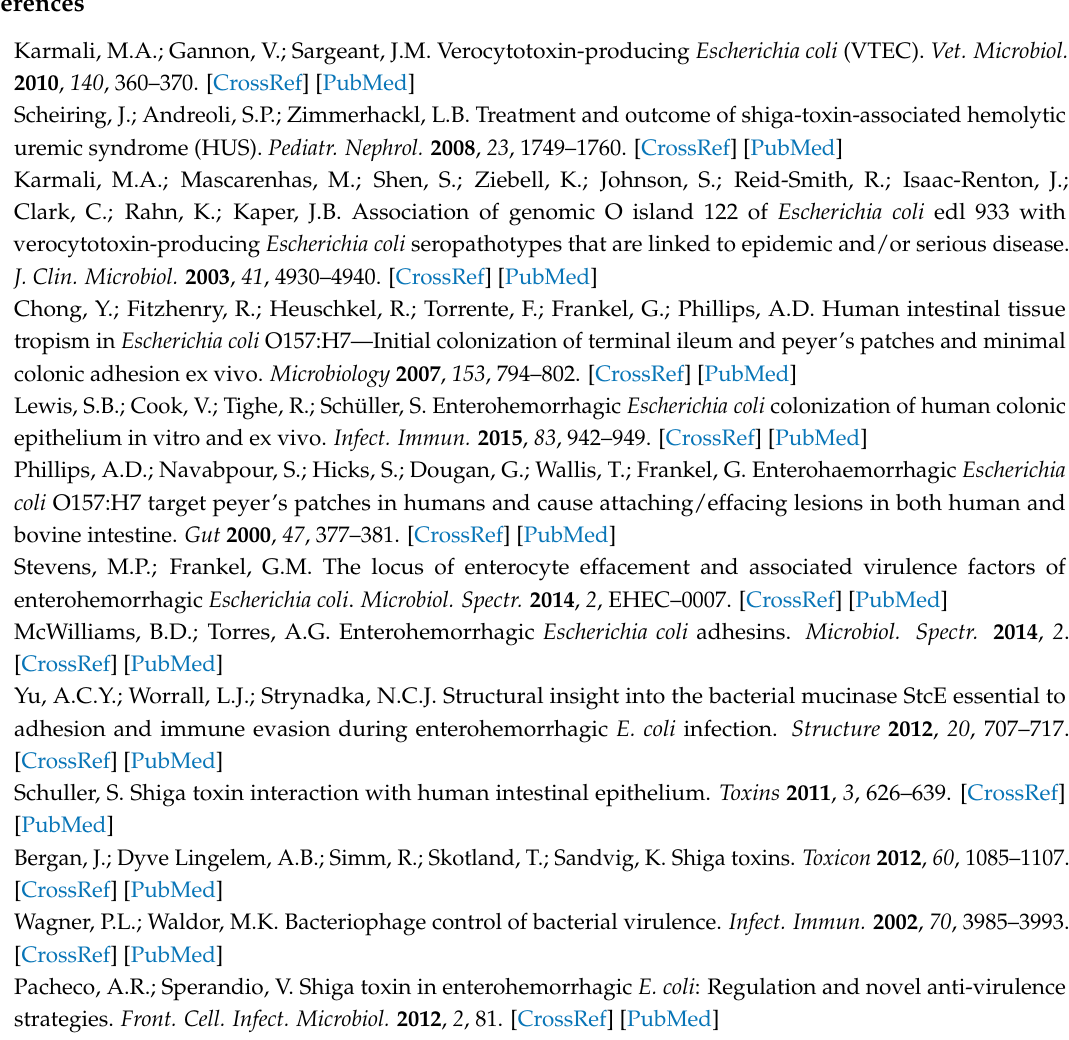
and table. S.S., L.E.-M. and S.B.-D. proof-edited the manuscript. Funding: This research received no external